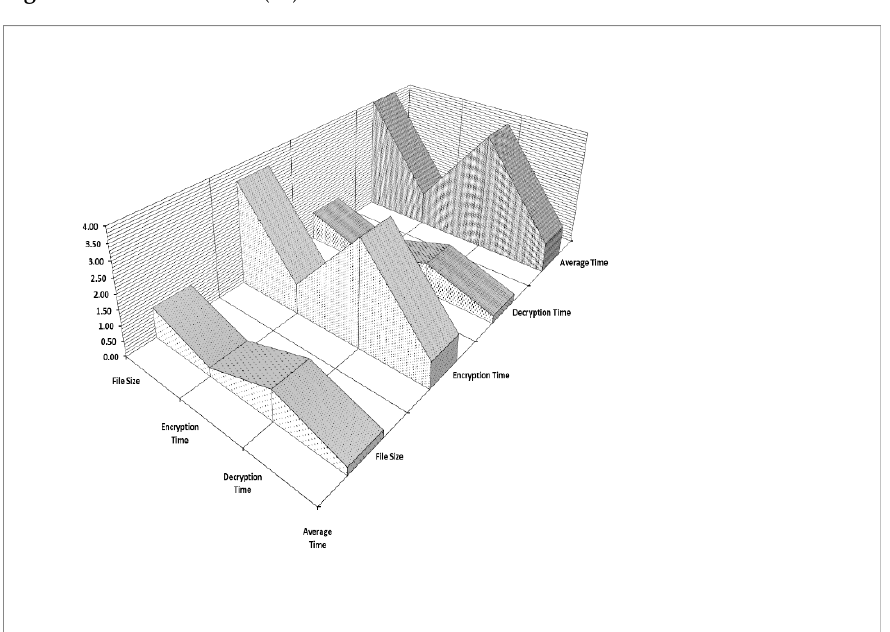
Figure 10. Random index (RI) values.